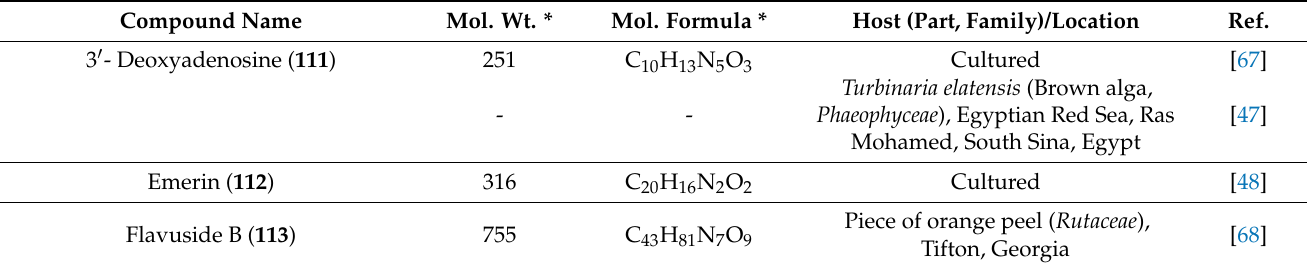
Table 8. Other nitrogenous compounds reported from A. nidulans .